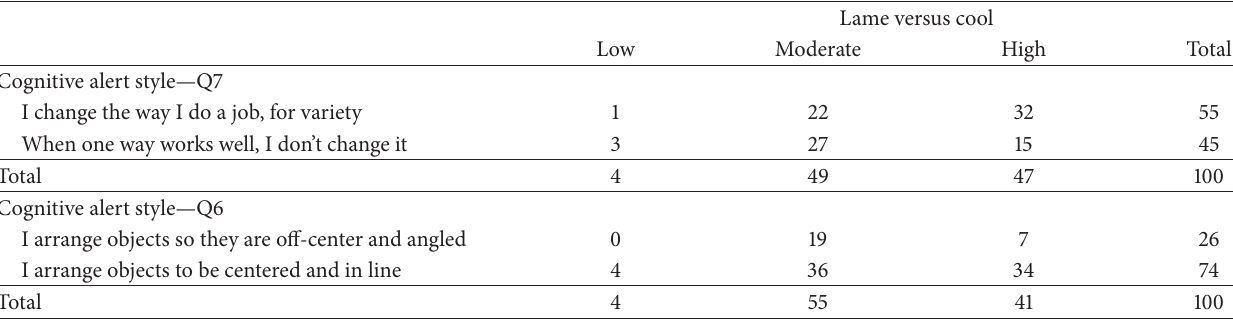
Table 15: The interpretation of Design no. 5 versus the way of students doing the Job (Q7) and the outcome of students doing the arranging (Q6).